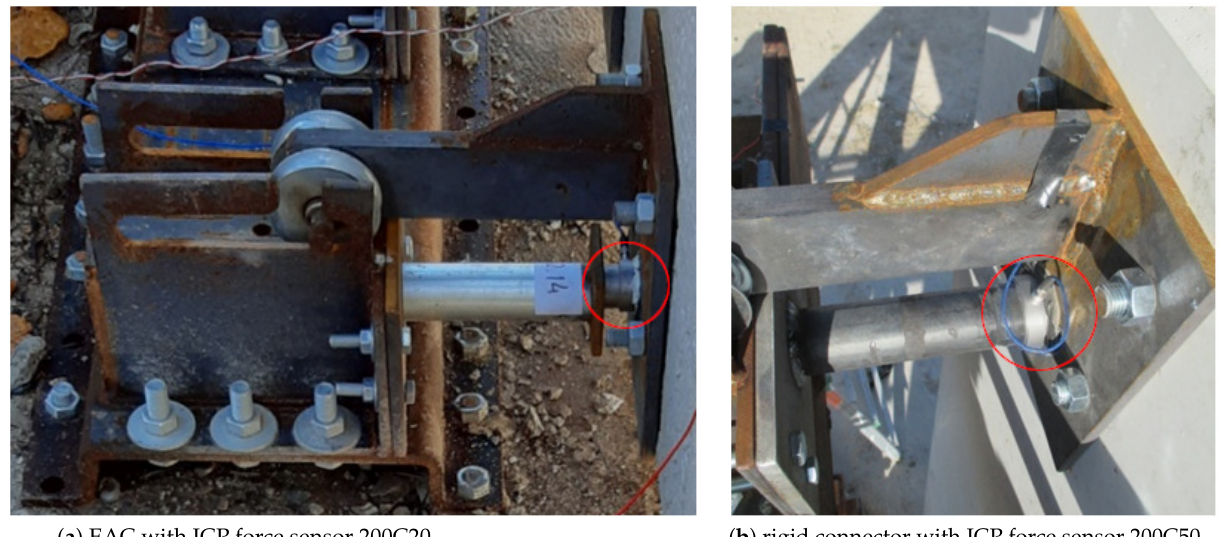
Figure 5. Detailed views of connectors on the blast testing site.